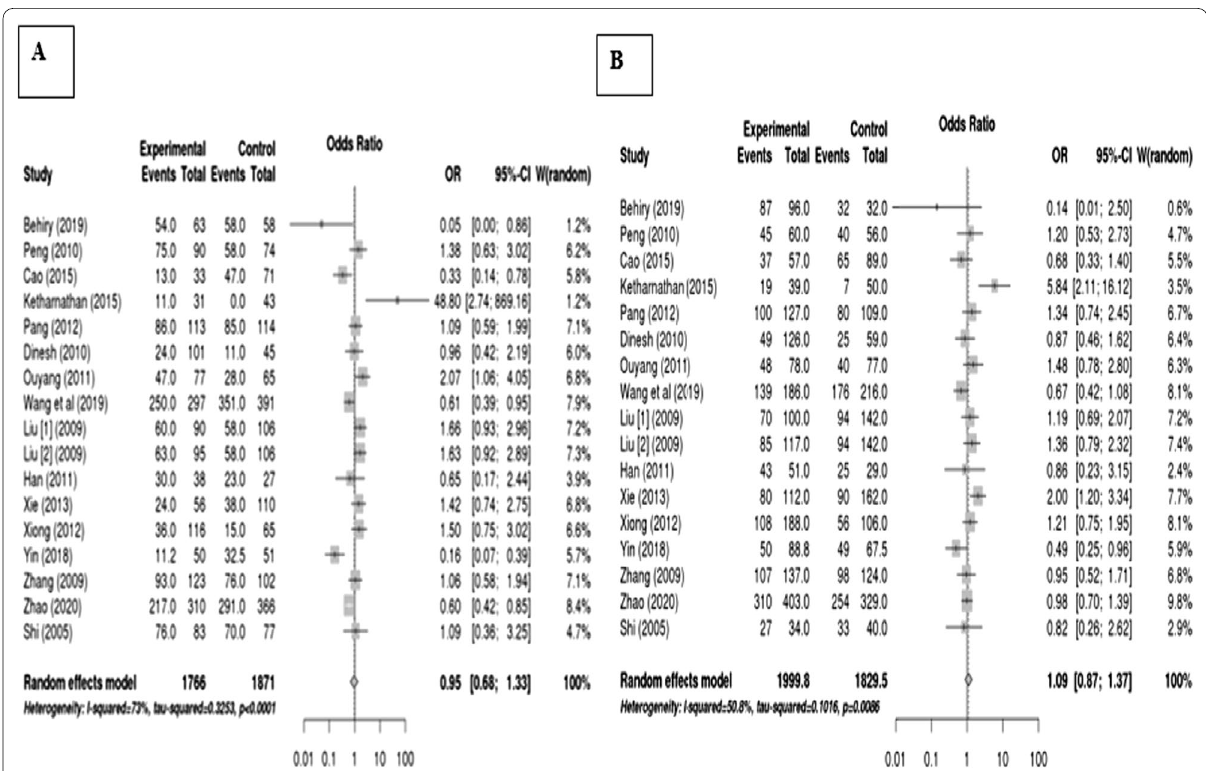
Fig. 3 Final analysis for rs2277923 association with congenital heart diseases A: homozygote forest plot and B: heterozygote forest